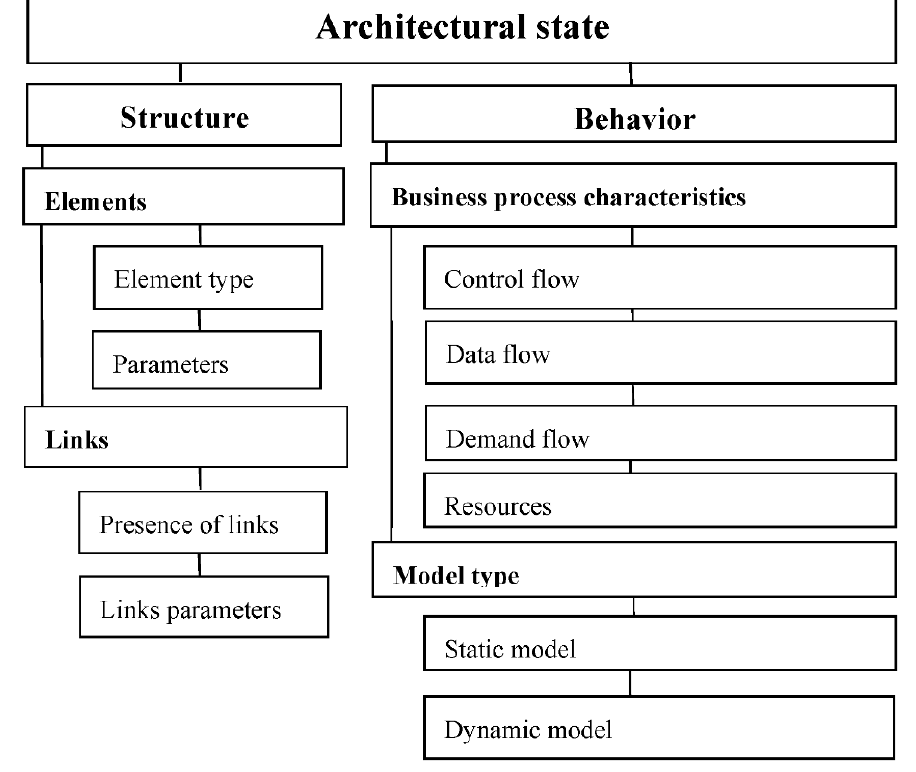
Figure 5. Architectural